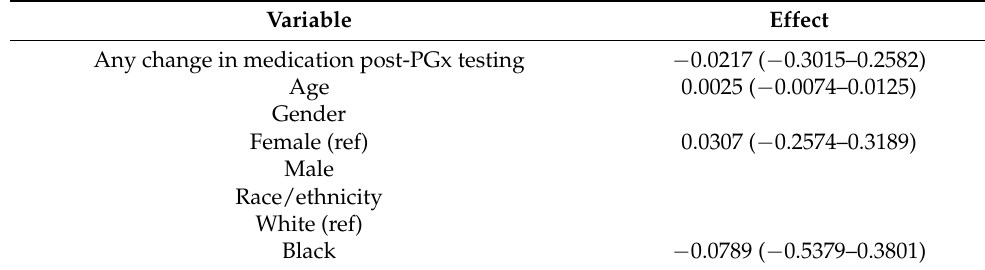
Table 7. Effect of change in medication post-pharmacogenomic (PGx) testing on patient pain scale (N =